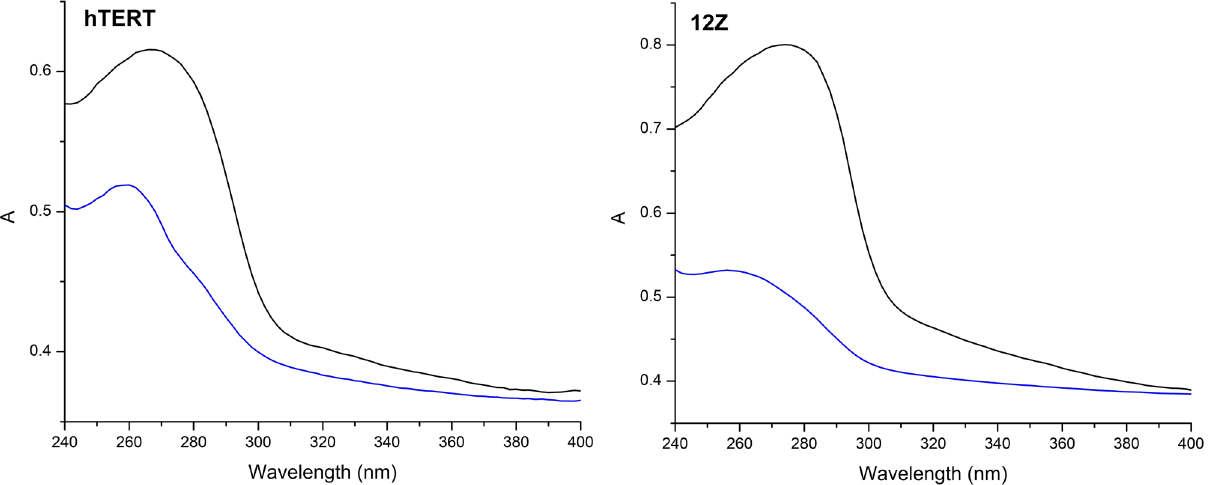
Figure 5. Absorption spectra of cell nuclei samples from unaffected cells (black) and cells treated with complex (10 μM) for 24 h (blue) for hTERT (left) and 12Z (right) cell